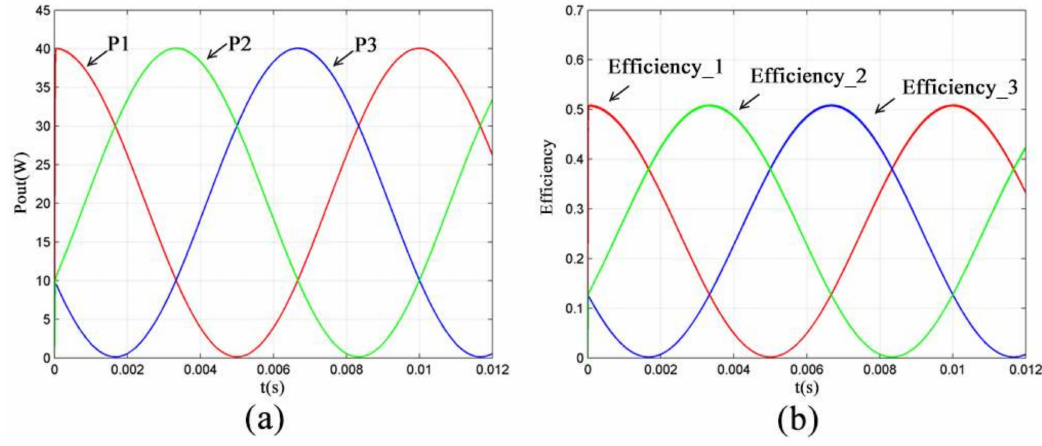
Figure 9. Waveforms of the output power and transfer efficiency against time in the three-receiver system: ( a ) output power; ( b ) transfer